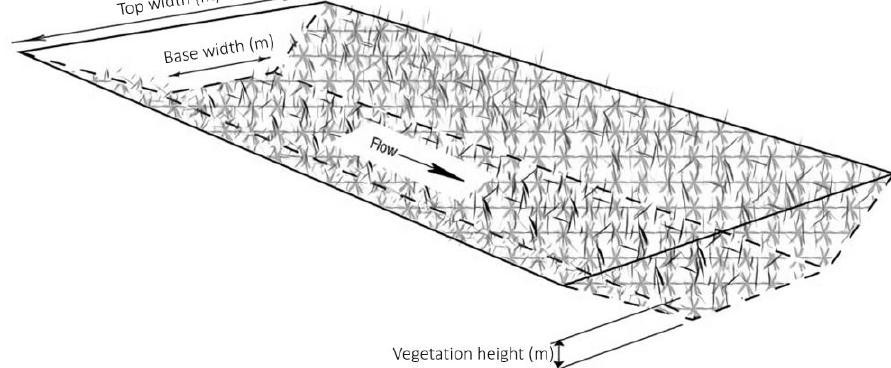
Figure A4. The schematic diagram of swales [112]. Table A4. Parameters of two types of swales in MUSIC.